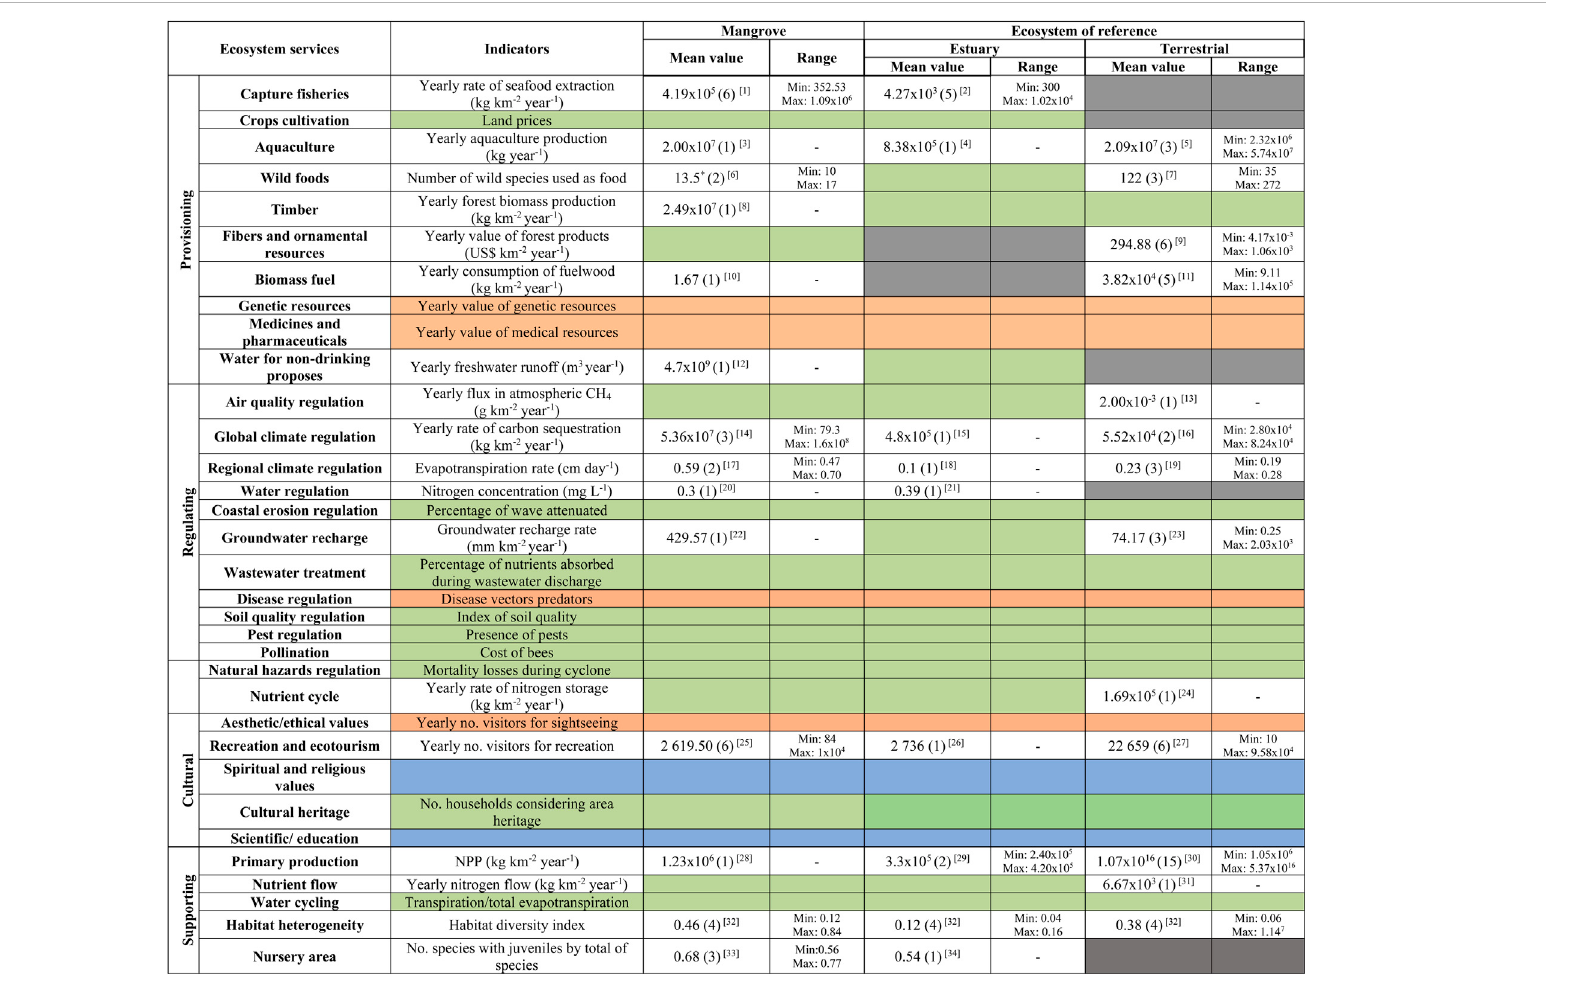
TABLE3| Ecosystem Services identi fi edand quanti fi ed(meanvaluesandrange) inmangrove,estuaryandlandsystemsfromTropicalAfrica(adapted fromLaykeetal.,2012).Thenumberofestimatesusedtocalculate the mean is indicated in